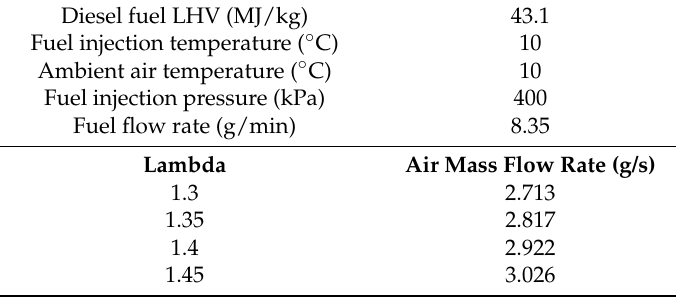
Table 1. Input data and flow rates for the 6 kW heater experiments. LHV—lower heating value.